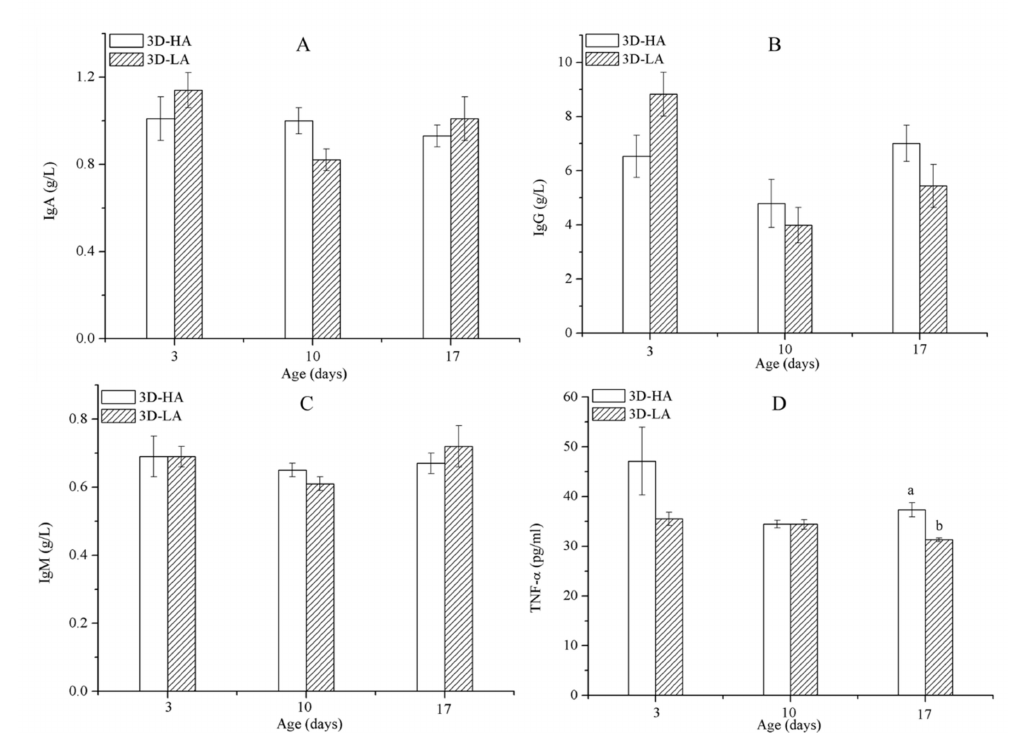
Figure 4. Immunoglobulin levels IgA ( A ), IgG ( B ), IgM ( C ), and tumor necrosis factor (TNF)- α ( D ) concentrations among calves of D3-HA and D3-LA. Data represent mean ± SEM. a,b Values having different letters within the same column are significantly different ( p ≤ 0.05).